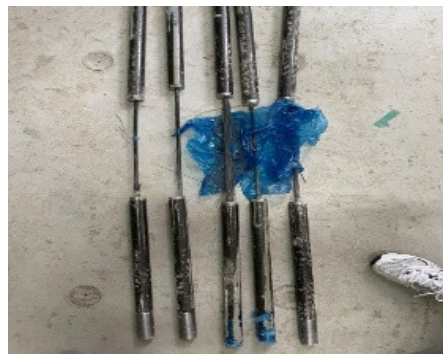
Figure 4. Fracture location image. Table 1. Tensile test results of the sample specimen.